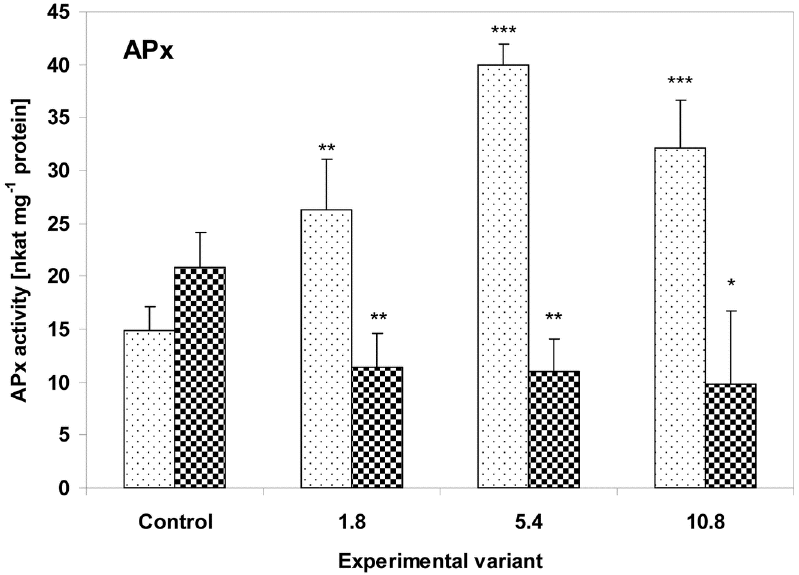
Fig 4. Activity of APx in the leaves of zucchini (square without filling) and cucumber (square with dots) grown on the control and sewage sludge amended soil. For further explanation, see Fig